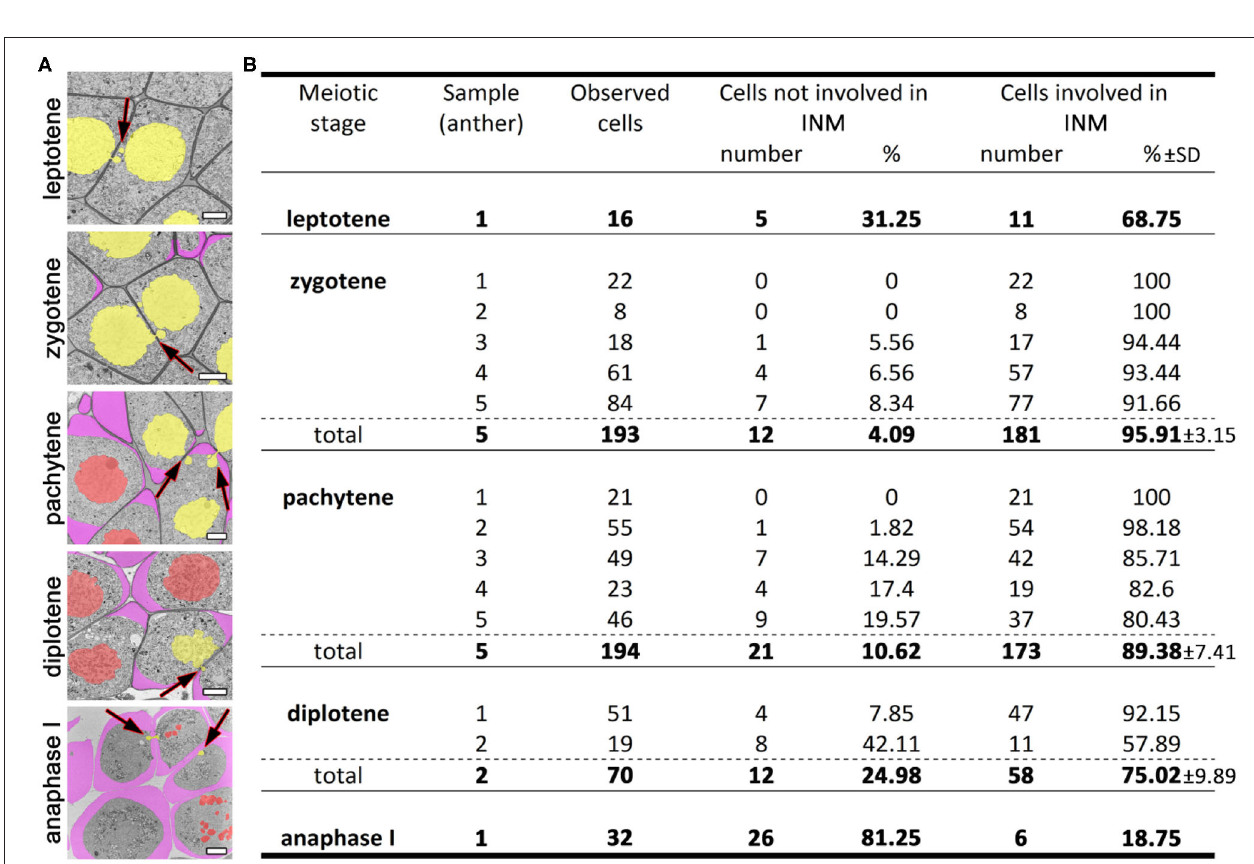
FIGURE 2 | INM frequencies at different meiotic stages. (A) Tobacco meiocytes from leptotene to anaphase I. Yellow denotes migrating nuclei, red non-migrating nuclei, and purple a callose wall; the arrows indicate the NPs crossing a cell wall. (B) Statistical data on the INM frequencies. SD, standard deviation. Scale bars are 5 µ